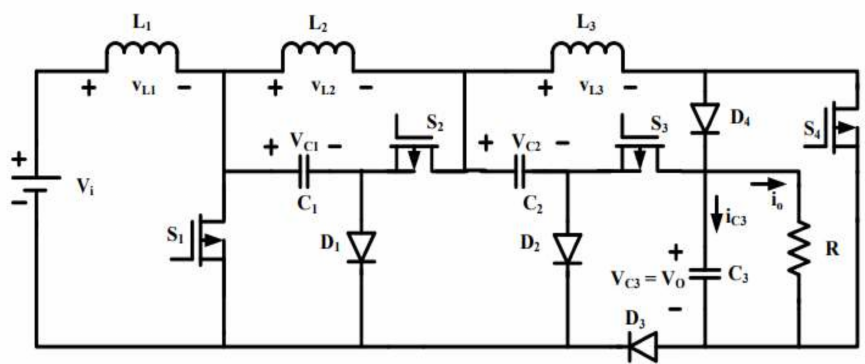
Figure 3. Circuit diagram of a high-gain converter.